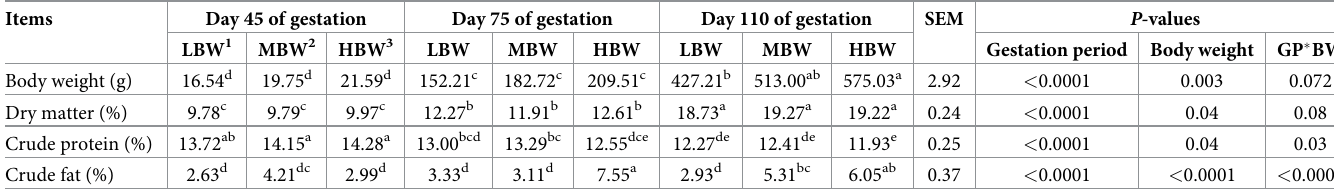
Table 4. Body weight and routine nutrient concentrations of fetal pigs with LBW, MBW, and HBW at different gestation period (n = 8).